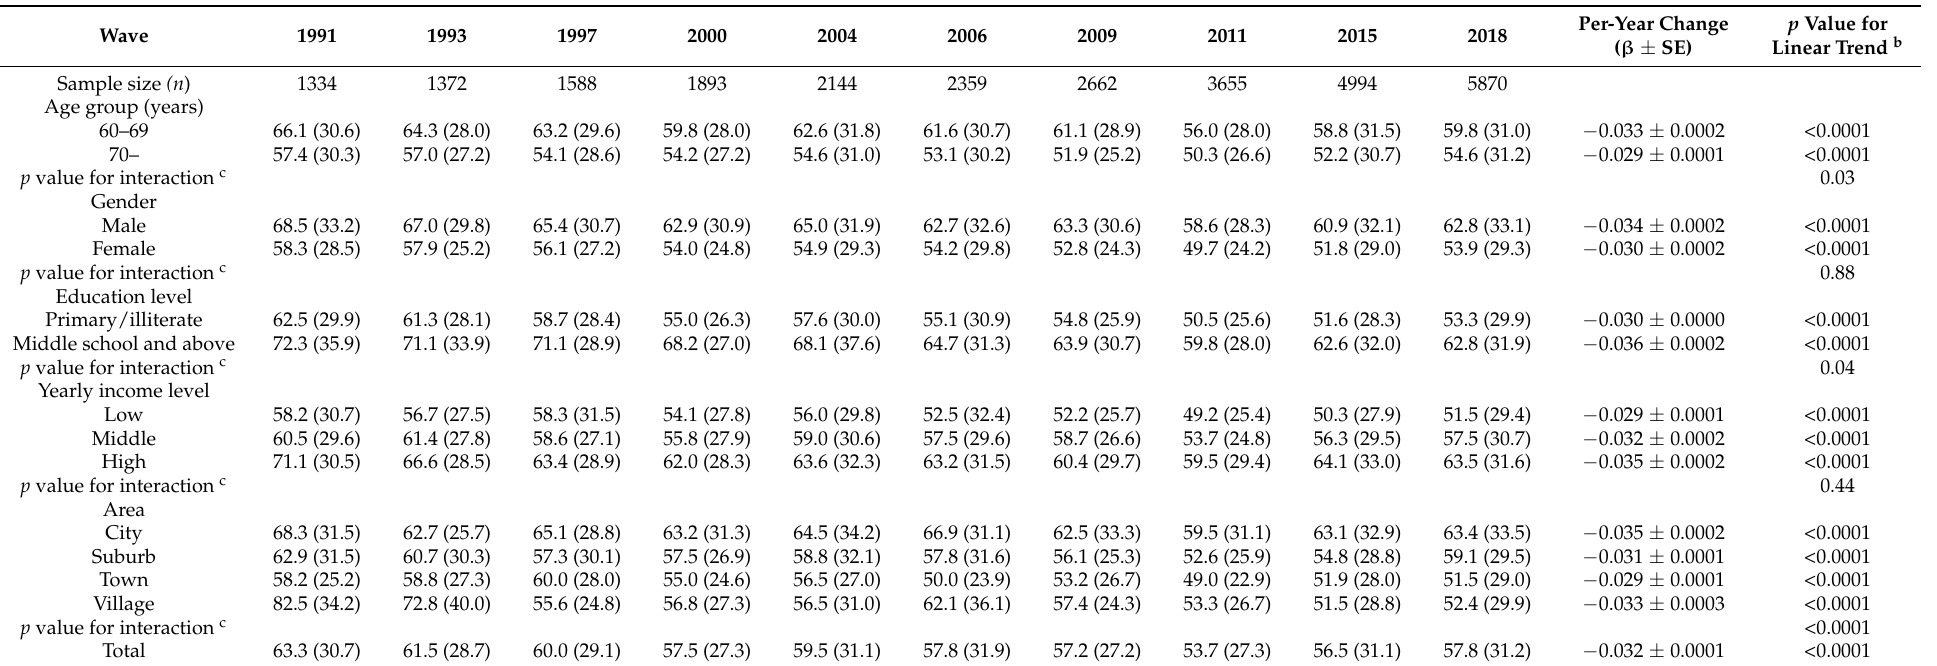
Table 2. Trends in daily protein intake (g) among the elderly Chinese, 1991 to 2018 a